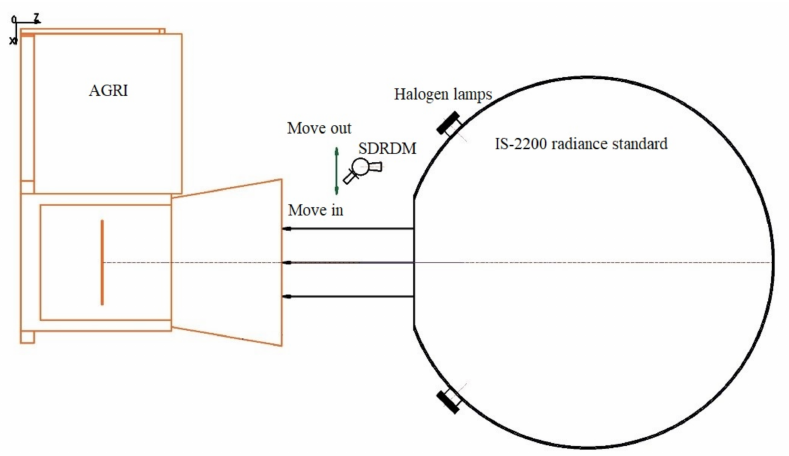
Figure 3. The AGRI and the SDRDM calibration method diagram.